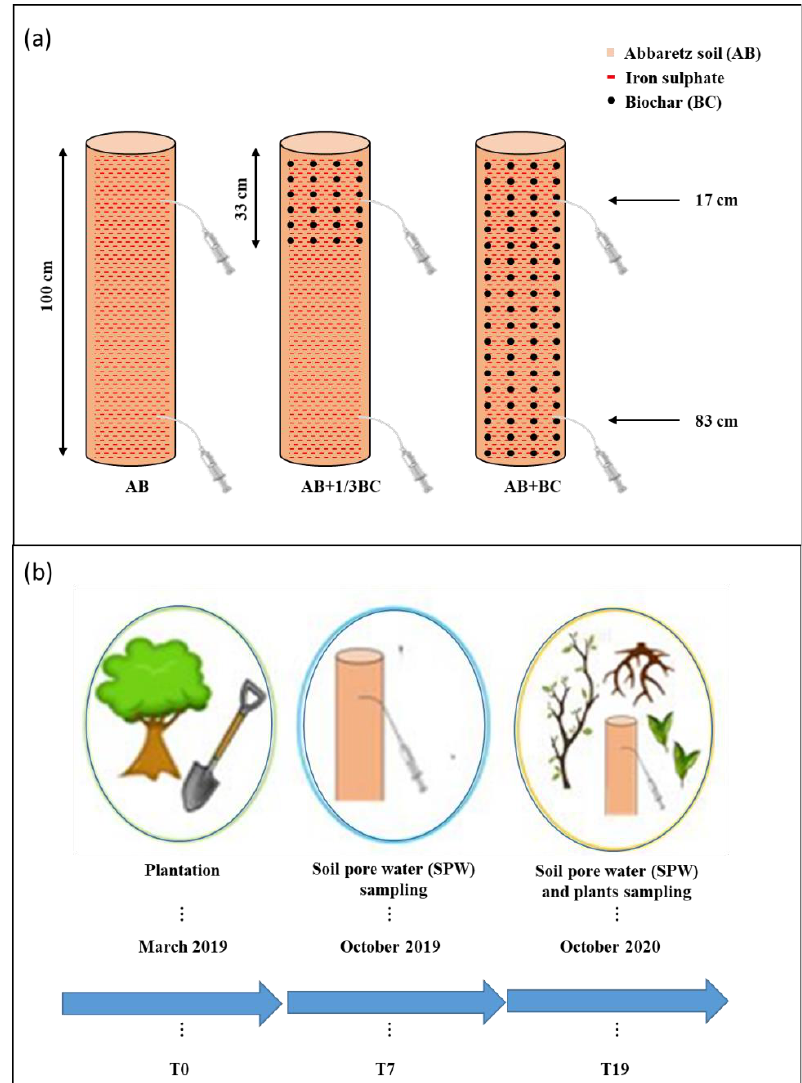
Figure 1. Representation of the experimental design ( a ) and monitoring ( b ) (adapted from